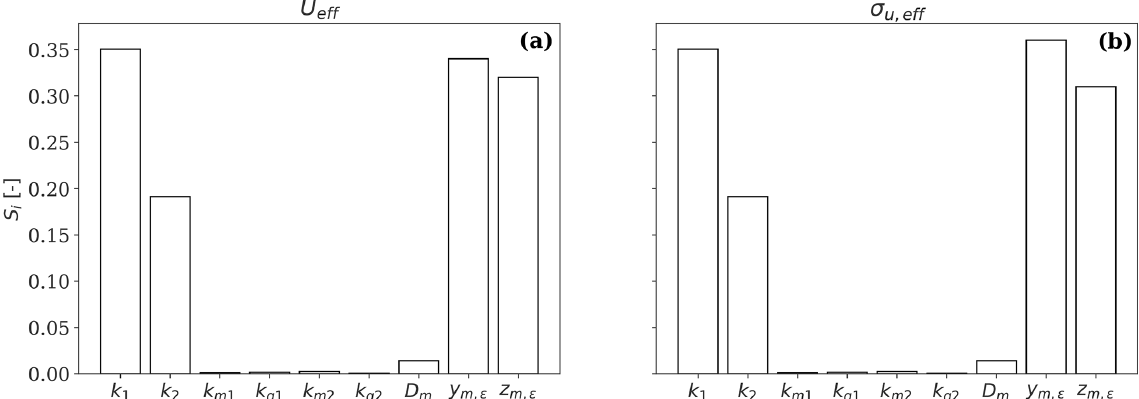
Figure B1. Variance decomposition (Sobol indices) for the rotor-effective wind speed (a) and a measure of the rotor-effective turbulence (b)